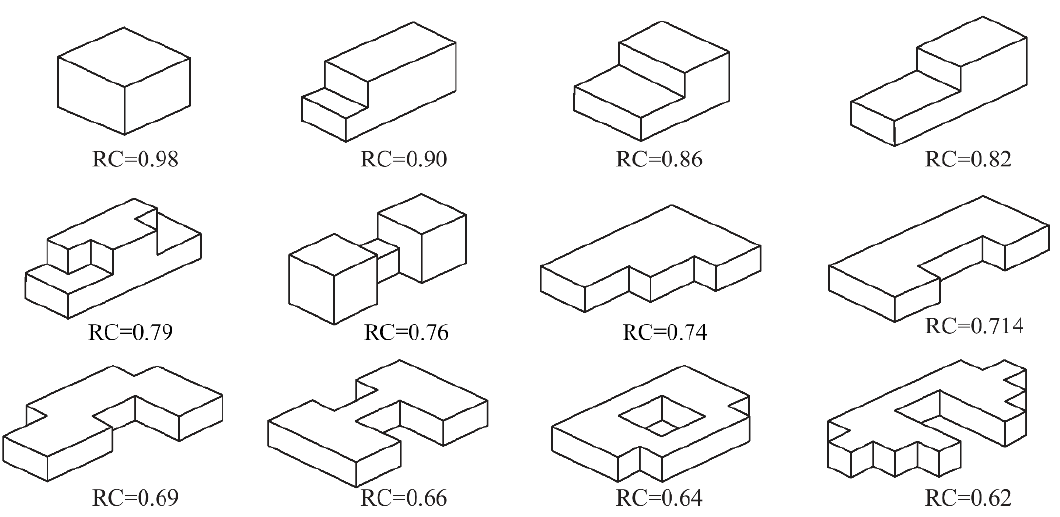
Appl. Sci. 2019 , 9 , x Figure 1. Individual building shapes with di ff erent relative compactness [31]. Figure 1. Individual building shapes with different relative compactness [31].